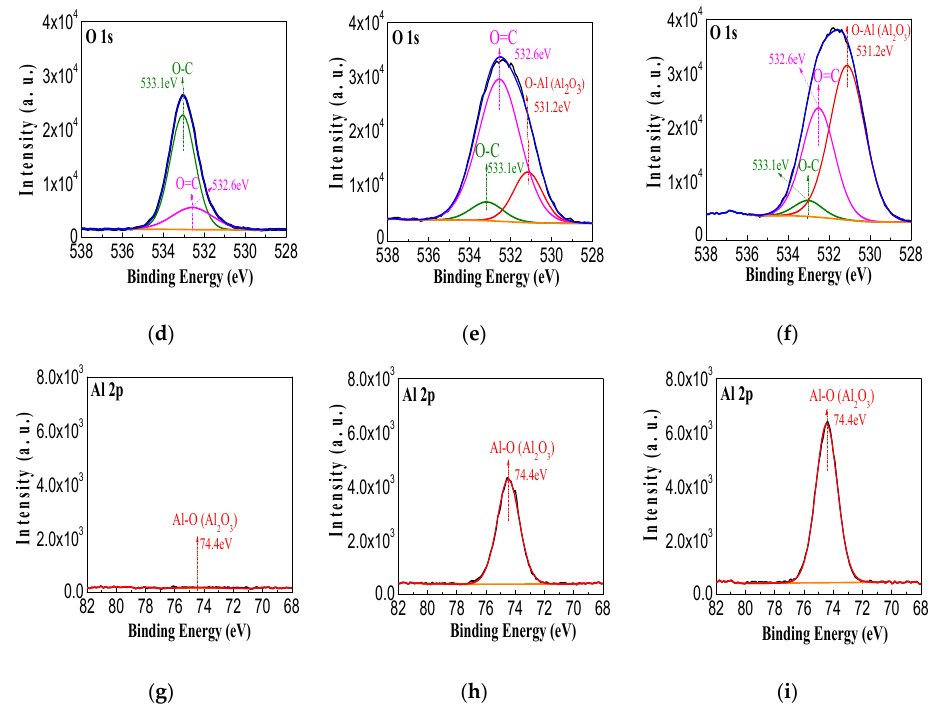
Figure 6. The C 1s, O 1s and Al 2p XPS spectra of fresh pressboard surface ( a , d , g ); pressboard surface sputtered for 60 min ( b , e , h ); and 90 min ( c , f , i ).